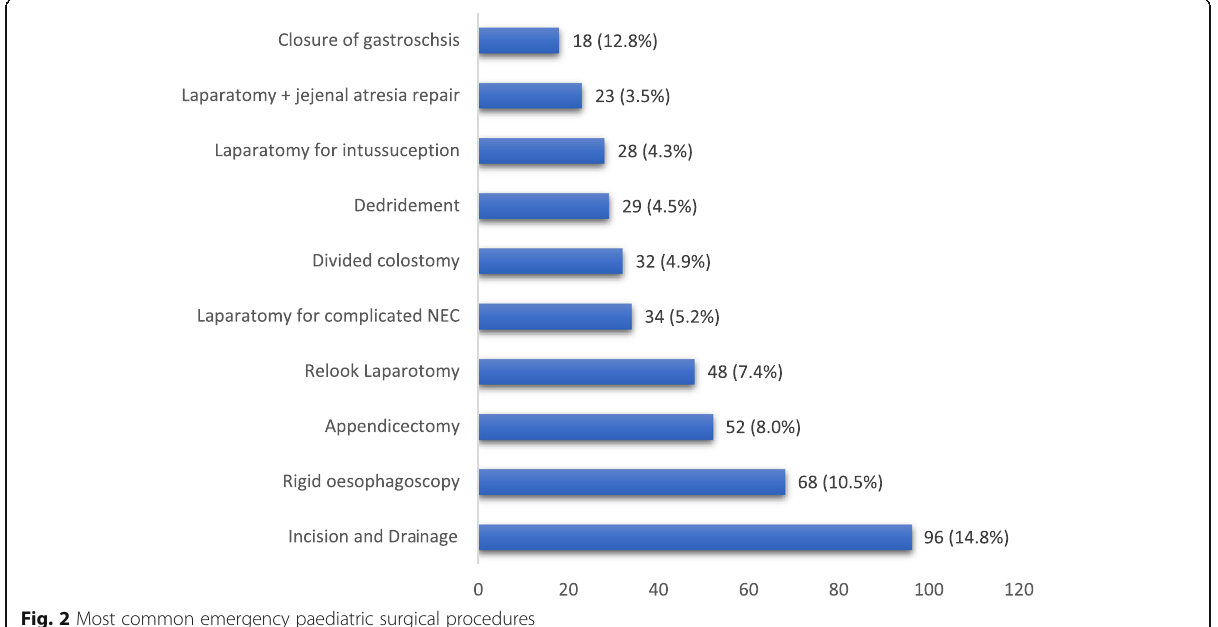
Fig. 2 Most common emergency paediatric surgical